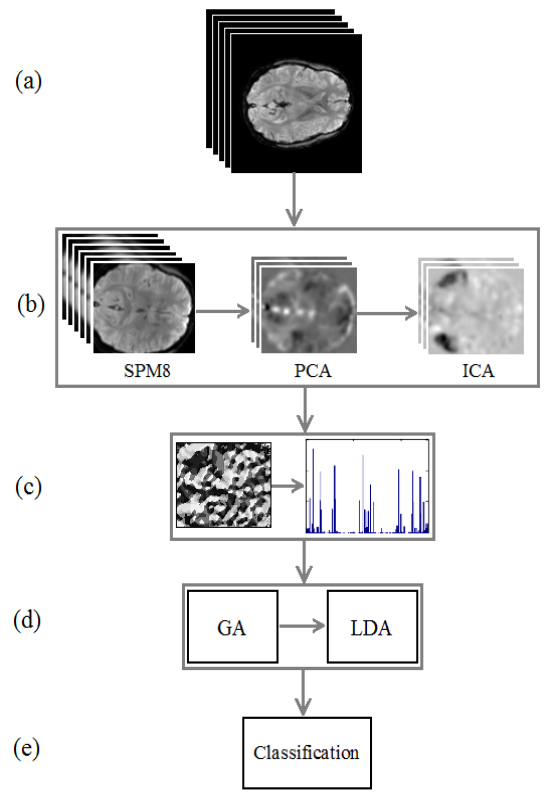
Figure 1. Overall procedure of proposed method: (a) original data, (b) preprocessing using SPM8, PCA, and ICA methods, (c) feature selection using LBP method and its histogram, (d) feature selection using GA and LDA methods, (e) classification using the Euclidean- based